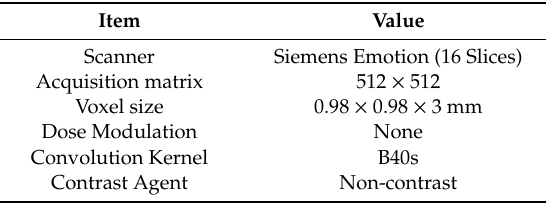
Table 2. CT protocol for treatment planning.